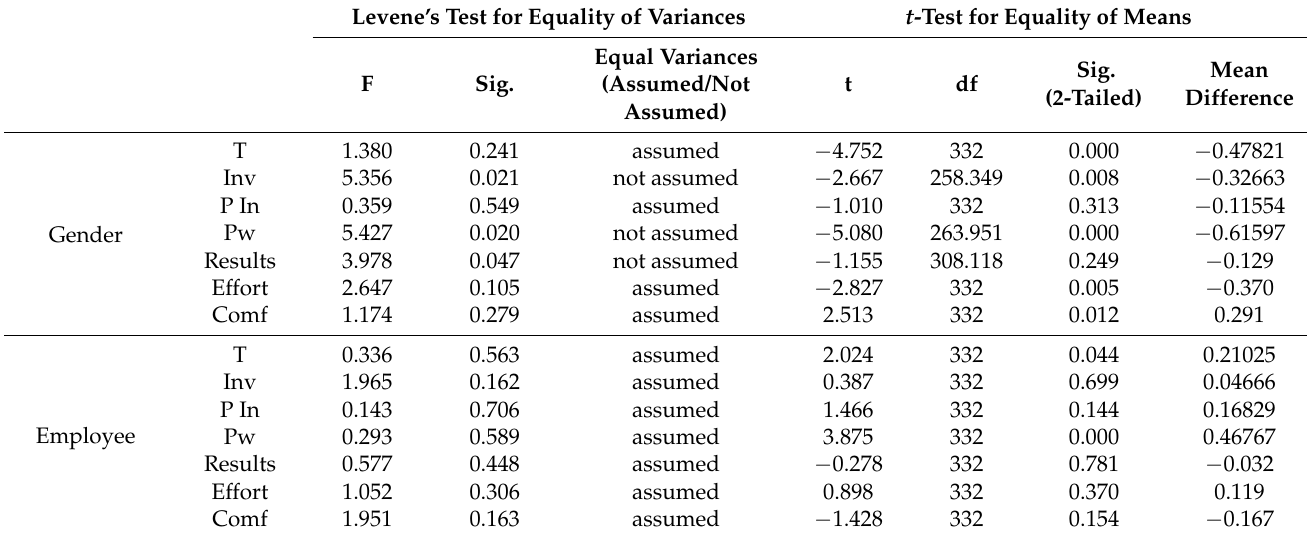
Table 8. Independent Samples T-Test for Gender and Employee variables (in students’ case).